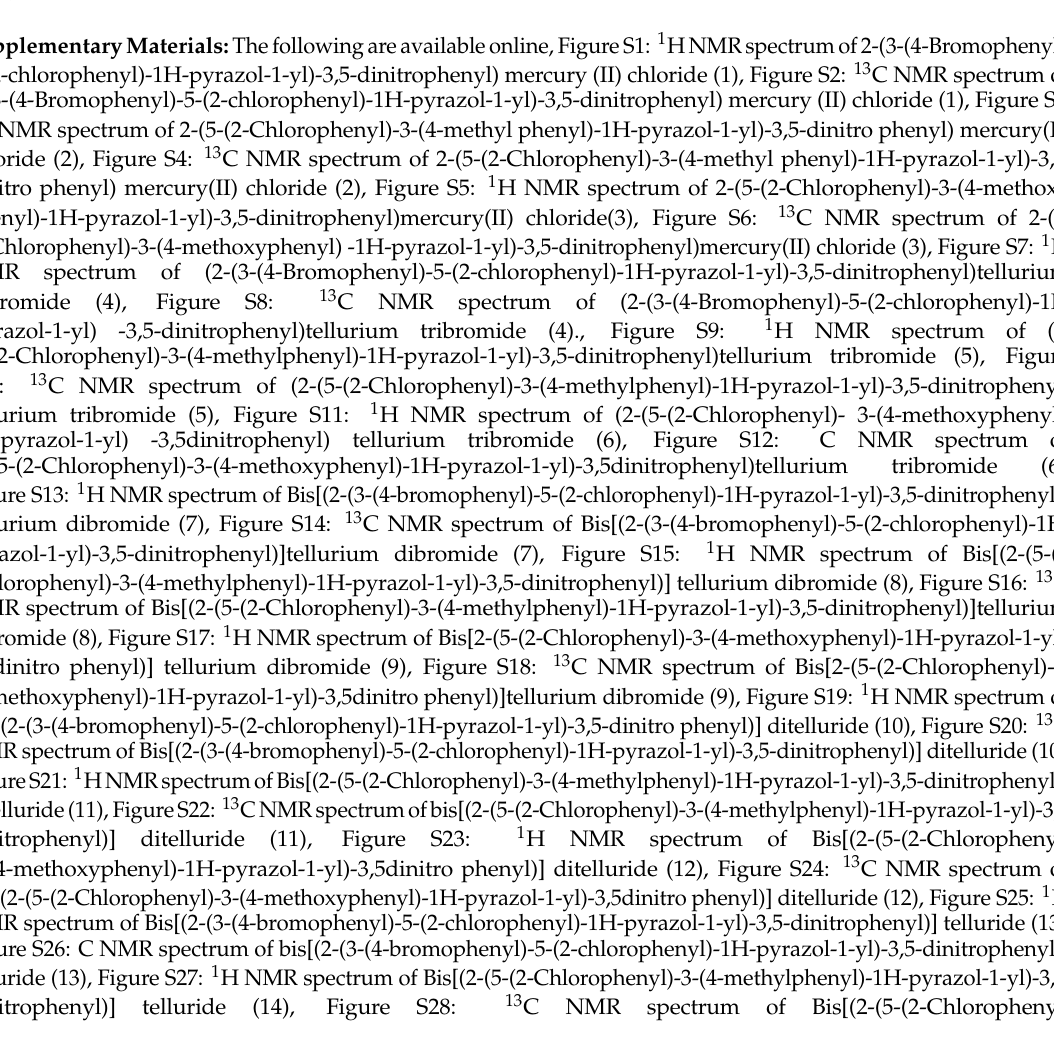
5-(2-chlorophenyl)-1H-pyrazol-1-yl)-3,5-dinitrophenyl) mercury (II) chloride (1), Figure S2: 13 C NMR spectrum of 2-(3-(4-Bromophenyl)-5-(2-chlorophenyl)-1H-pyrazol-1-yl)-3,5-dinitrophenyl) mercury (II) chloride (1), Figure S3: 1 H NMR spectrum of 2-(5-(2-Chlorophenyl)-3-(4-methyl phenyl)-1H-pyrazol-1-yl)-3,5-dinitro phenyl) mercury(II) chloride (2), Figure S4: 13 C NMR spectrum of 2-(5-(2-Chlorophenyl)-3-(4-methyl phenyl)-1H-pyrazol-1-yl)-3,5- dinitro phenyl) mercury(II) chloride (2), Figure S5: 1 H NMR spectrum of 2-(5-(2-Chlorophenyl)-3-(4-methoxy phenyl)-1H-pyrazol-1-yl)-3,5-dinitrophenyl)mercury(II) chloride(3), Figure S6: 13 C NMR spectrum of 2-(5- (2-Chlorophenyl)-3-(4-methoxyphenyl) -1H-pyrazol-1-yl)-3,5-dinitrophenyl)mercury(II) chloride (3), Figure S7: 1 H NMR spectrum of (2-(3-(4-Bromophenyl)-5-(2-chlorophenyl)-1H-pyrazol-1-yl)-3,5-dinitrophenyl)tellurium tribromide (4), Figure S8: 13 C NMR spectrum of (2-(3-(4-Bromophenyl)-5-(2-chlorophenyl)-1H -pyrazol-1-yl) -3,5-dinitrophenyl)tellurium tribromide (4)., Figure S9: 1 H NMR spectrum of (2- (5-(2-Chlorophenyl)-3-(4-methylphenyl)-1H-pyrazol-1-yl)-3,5-dinitrophenyl)tellurium tribromide (5), Figure S10: 13 C NMR spectrum of (2-(5-(2-Chlorophenyl)-3-(4-methylphenyl)-1H-pyrazol-1-yl)-3,5-dinitrophenyl) tellurium tribromide (5), Figure S11: 1 H NMR spectrum of (2-(5-(2-Chlorophenyl)- 3-(4-methoxyphenyl)- 1H-pyrazol-1-yl) -3,5dinitrophenyl) tellurium tribromide (6), Figure S12: C NMR spectrum of (2-(5-(2-Chlorophenyl)-3-(4-methoxyphenyl)-1H-pyrazol-1-yl)-3,5dinitrophenyl)tellurium tribromide (6), Figure S13: 1 H NMR spectrum of Bis[(2-(3-(4-bromophenyl)-5-(2-chlorophenyl)-1H-pyrazol-1-yl)-3,5-dinitrophenyl)] tellurium dibromide (7), Figure S14: 13 C NMR spectrum of Bis[(2-(3-(4-bromophenyl)-5-(2-chlorophenyl)-1H- pyrazol-1-yl)-3,5-dinitrophenyl)]tellurium dibromide (7), Figure S15: 1 H NMR spectrum of Bis[(2-(5-(2 -Chlorophenyl)-3-(4-methylphenyl)-1H-pyrazol-1-yl)-3,5-dinitrophenyl)] tellurium dibromide (8), Figure S16: 13 C NMR spectrum of Bis[(2-(5-(2-Chlorophenyl)-3-(4-methylphenyl)-1H-pyrazol-1-yl)-3,5-dinitrophenyl)]tellurium dibromide (8), Figure S17: 1 H NMR spectrum of Bis[2-(5-(2-Chlorophenyl)-3-(4-methoxyphenyl)-1H-pyrazol-1-yl)- 3,5dinitro phenyl)] tellurium dibromide (9), Figure S18: 13 C NMR spectrum of Bis[2-(5-(2-Chlorophenyl)-3- (4-methoxyphenyl)-1H-pyrazol-1-yl)-3,5dinitro phenyl)]tellurium dibromide (9), Figure S19: 1 H NMR spectrum of Bis[(2-(3-(4-bromophenyl)-5-(2-chlorophenyl)-1H-pyrazol-1-yl)-3,5-dinitro phenyl)] ditelluride (10), Figure S20: 13 C NMR spectrum of Bis[(2-(3-(4-bromophenyl)-5-(2-chlorophenyl)-1H-pyrazol-1-yl)-3,5-dinitrophenyl)] ditelluride (10), FigureS21: 1 HNMRspectrumofBis[(2-(5-(2-Chlorophenyl)-3-(4-methylphenyl)-1H-pyrazol-1-yl)-3,5-dinitrophenyl)] ditelluride(11),FigureS22: 13 CNMRspectrumofbis[(2-(5-(2-Chlorophenyl)-3-(4-methylphenyl)-1H-pyrazol-1-yl)-3,5- dinitrophenyl)] ditelluride (11), Figure S23: 1 H NMR spectrum of Bis[(2-(5-(2-Chlorophenyl) -3-(4-methoxyphenyl)-1H-pyrazol-1-yl)-3,5dinitro phenyl)] ditelluride (12), Figure S24: 13 C NMR spectrum of Bis[(2-(5-(2-Chlorophenyl)-3-(4-methoxyphenyl)-1H-pyrazol-1-yl)-3,5dinitro phenyl)] ditelluride (12), Figure S25: 1 H NMR spectrum of Bis[(2-(3-(4-bromophenyl)-5-(2-chlorophenyl)-1H-pyrazol-1-yl)-3,5-dinitrophenyl)] telluride (13), Figure S26: C NMR spectrum of bis[(2-(3-(4-bromophenyl)-5-(2-chlorophenyl)-1H-pyrazol-1-yl)-3,5-dinitrophenyl)] telluride (13), Figure S27: 1 H NMR spectrum of Bis[(2-(5-(2-Chlorophenyl)-3-(4-methylphenyl)-1H-pyrazol-1-yl)-3,5- dinitrophenyl)] telluride (14), Figure S28: 13 C NMR spectrum of